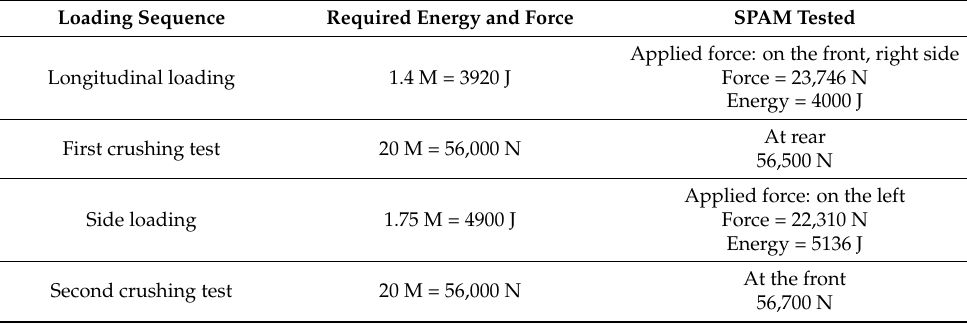
Figure 4. Spam forage harvester ROPS elements. Table 2. OECD Code 4—energy and force